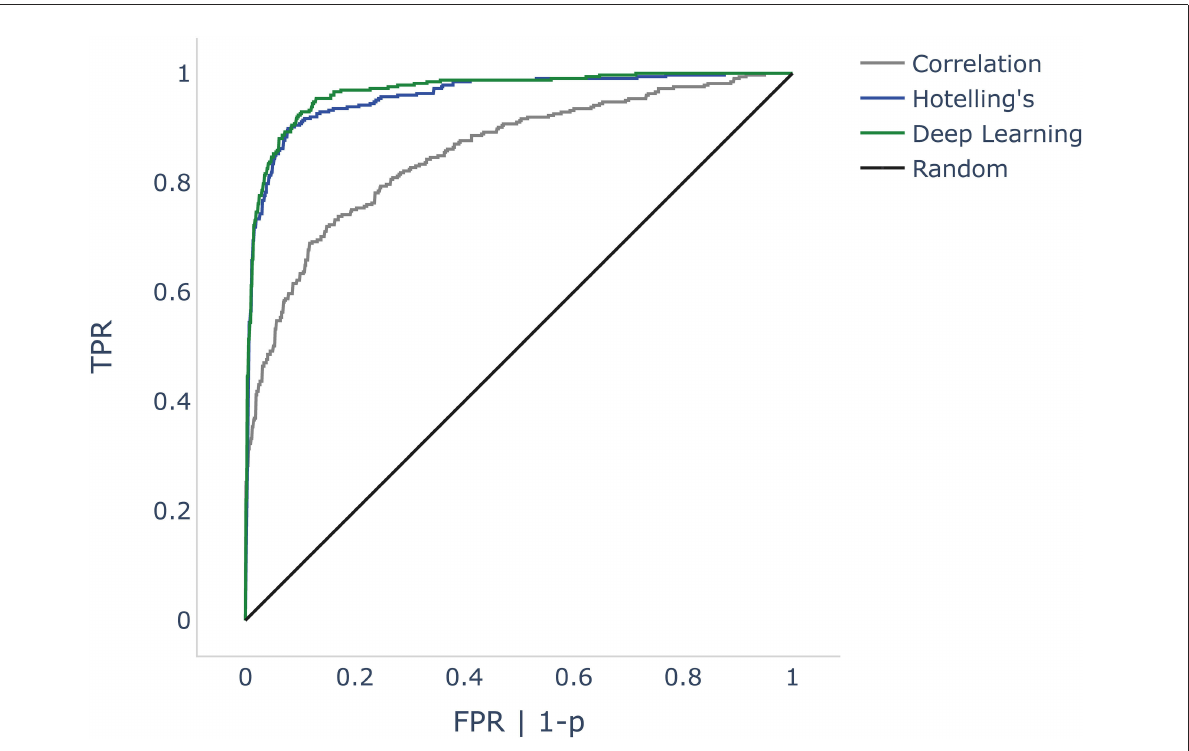
FIGURE4 ROC curves comparing correlation analysis, Hotelling’s T 2 test, and deep learning (DL) methods. The false positive rate (FPR) is the dependent variable (x-axis) in the DL and correlation algorithms. As Hotelling’s T 2 test does not specify probabilities, we used p -values instead. Since p is inversely proportional to probabilities, we mapped 1-p. The black line shows a random classifier. ROC, receiver operator characteristic; p, p